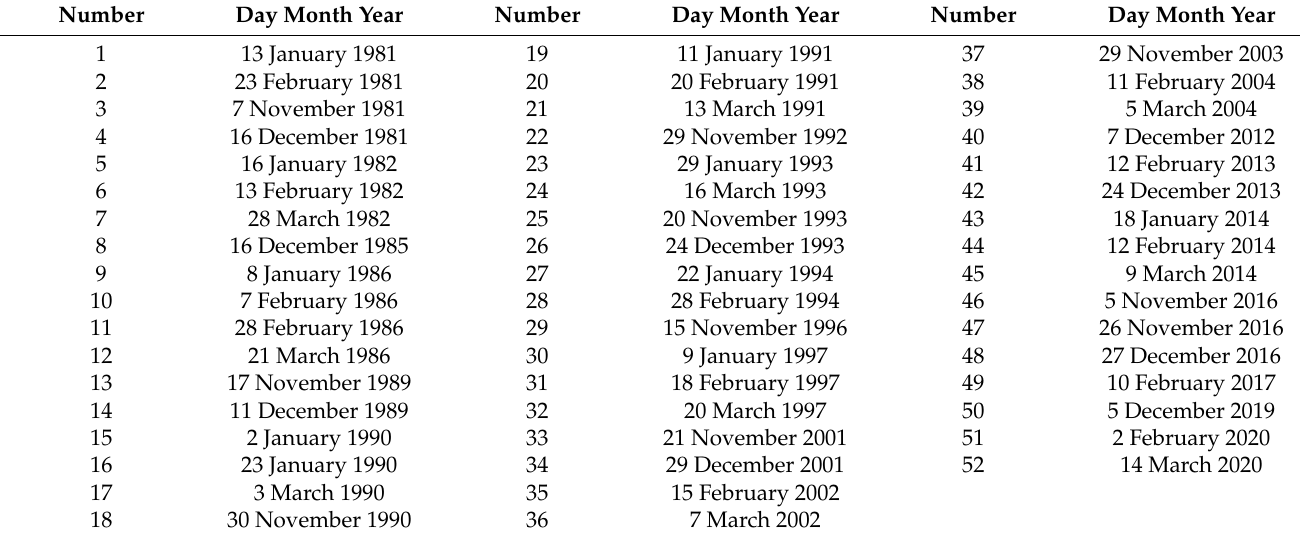
Table A1. The list of dates for day 0 of the strong intraseasonal EAWM